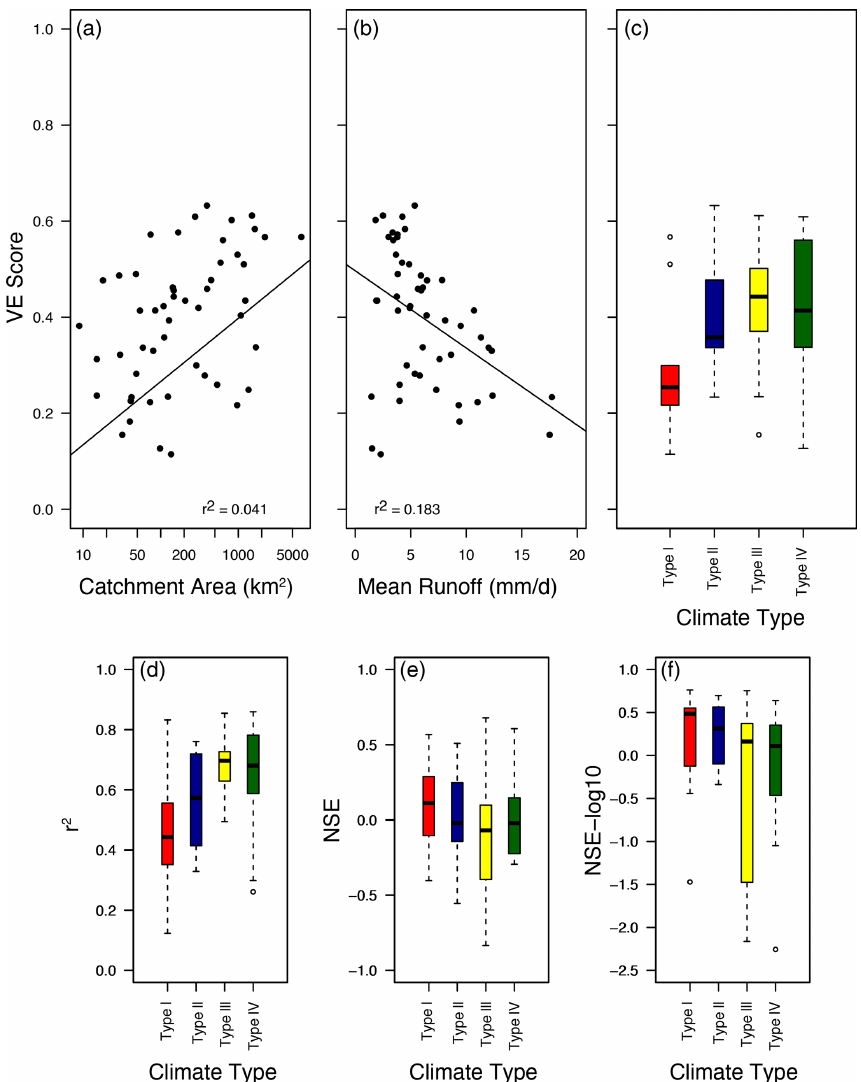
Figure 6. Diagnostic plots of volumetric efficiency (VE) results and comparison across metrics. Cross plots show the correlation of VE with (a) catchment area and (b) mean runoff. (c) Box and whisker plots show data from distribution of VE by climate type. Box and whisker plots show the median, interquartile range and 95% confidence intervals and outliers (dots). The regression in (a) is between the VE scores and ln(Catchment Area). (d–f) As in (c) for r 2 , NSE, and